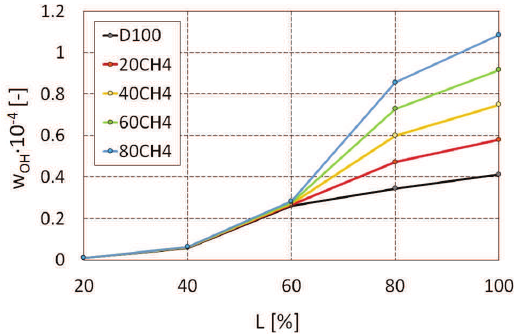
Fig. 9. The dependency of maximum hydroxyl radical mass fraction – W OH on engine relative load and methane content in fuel (engine